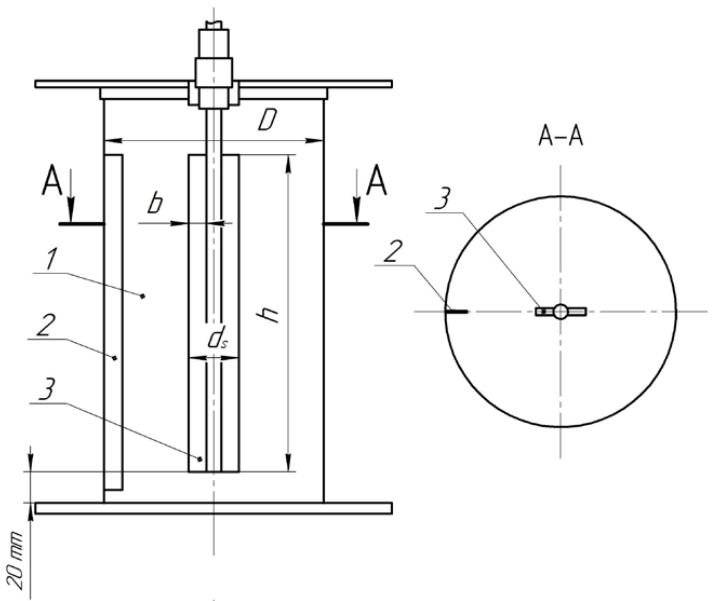
Figure 2. Diagram of the experimental apparatus with a paddle stirrer: 1—body; 2—removable partition; 3—stirrer paddle.